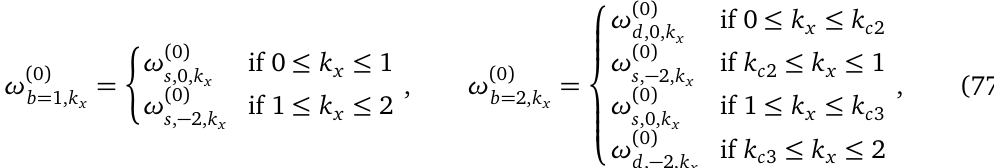
Figure 5: Lowest bands of the Bogoliubov spectrum as functions of k Blue and red curves correspond to density and spin modes, respectively; for better clarity, close to each band we write the corresponding values of the indices ( (cid:96) , ¯ K ) . The black dots mark the band crossing points, where a gap is expected to open as (cid:54) = 0. The interaction parameters are the same as Fig. soon as Ω R